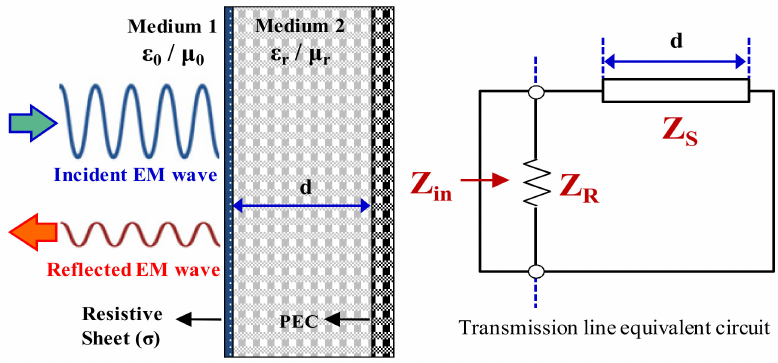
Figure 10. Salisbury screen absorber and transmission line